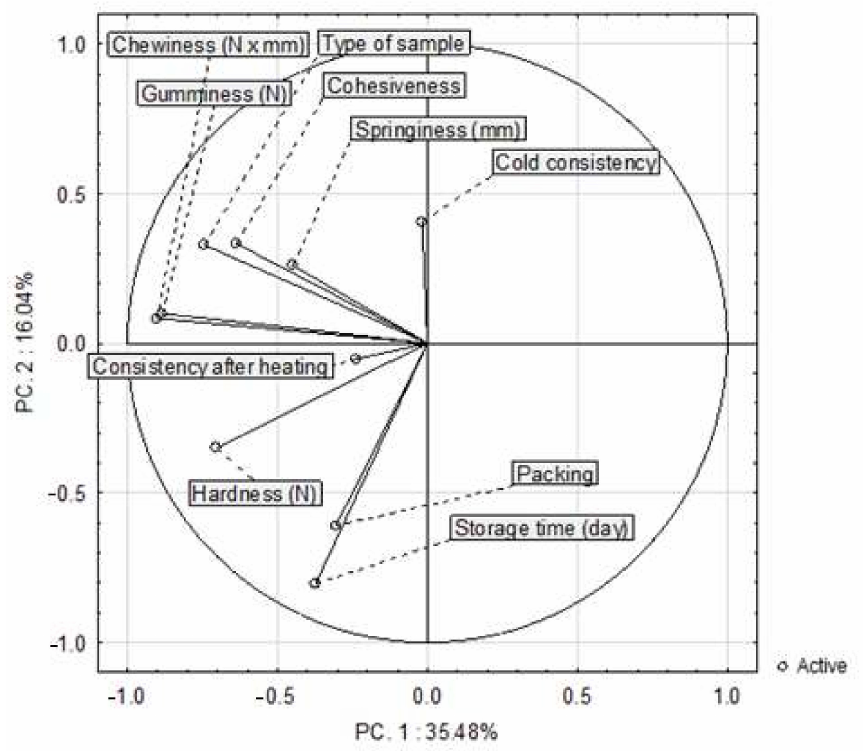
Figure 9. Changes in the value of the sensory and textural analysis in the poultry sausages depending on the type of sample, packing and time of storage ( n =